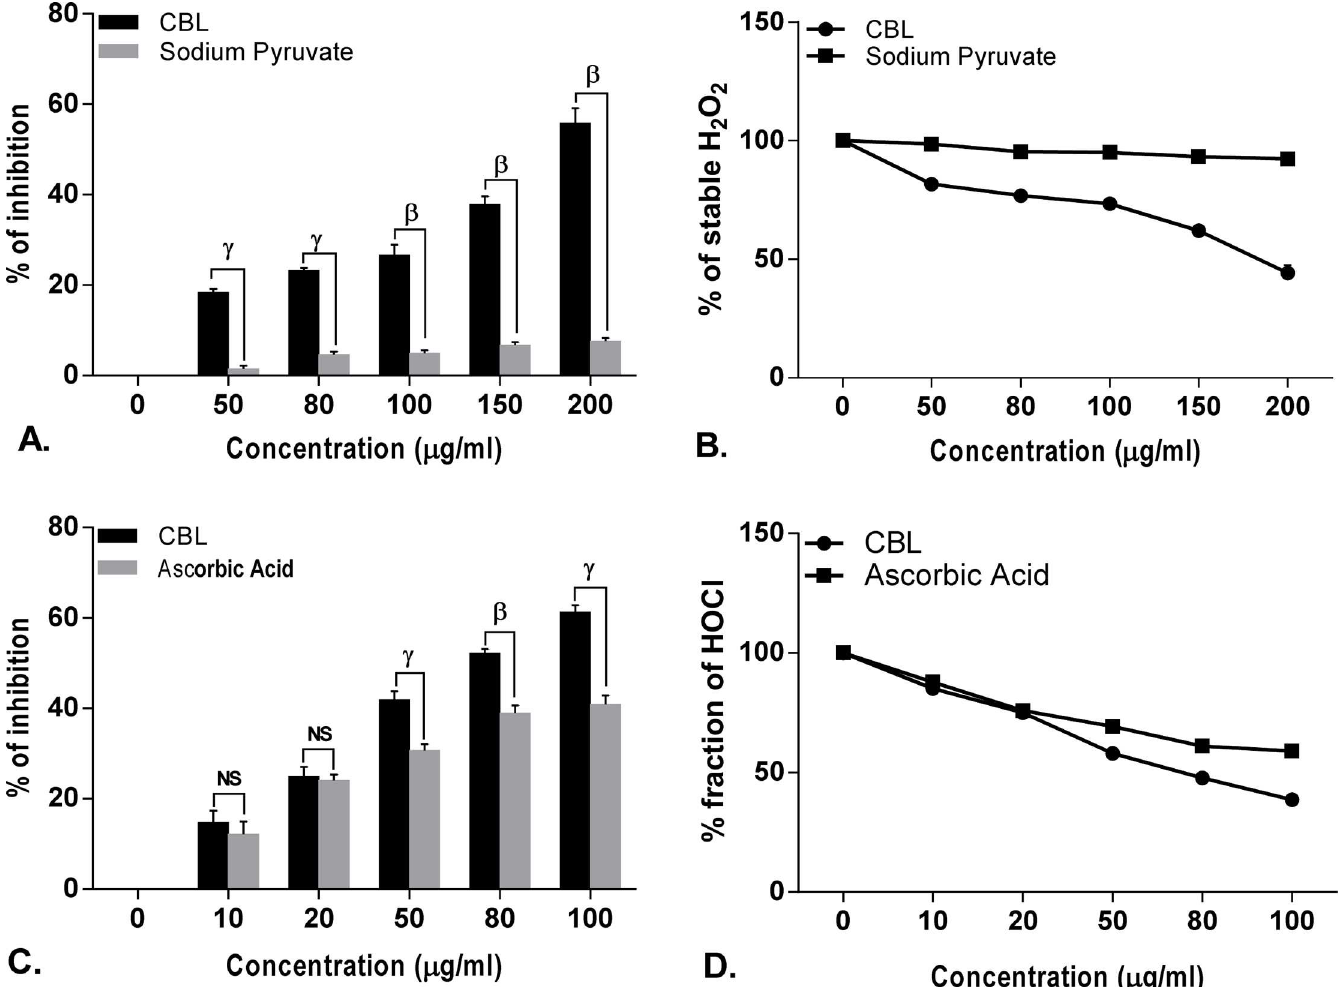
Fig 2. Antioxidant activity of Croton bonplandianus . (A) % of inhibition of hydrogen peroxide (H 2 O 2 )Vs standard sodium pyruvate; (B) depicts remaining unneutralized H 2 O 2 ; (C) % inhibition of Hypochlorous acid (HOCl) Vs standard ascorbic acid; (D) depicts unneutralized HOCl radicals. Data expressed as mean ± S.D (n = 6). α p < 0.05; β p < 0.01; γ p < 0.001; NS-Non significant when compared with